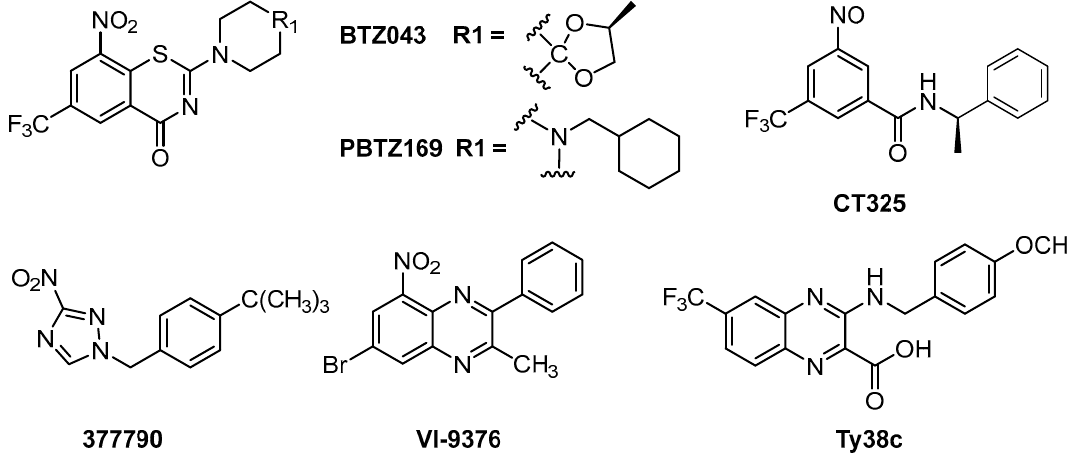
Figure 1. The chemical structures of some Decaprenylphosphoryl- β - D -ribose oxidase (DprE1) inhibitors.